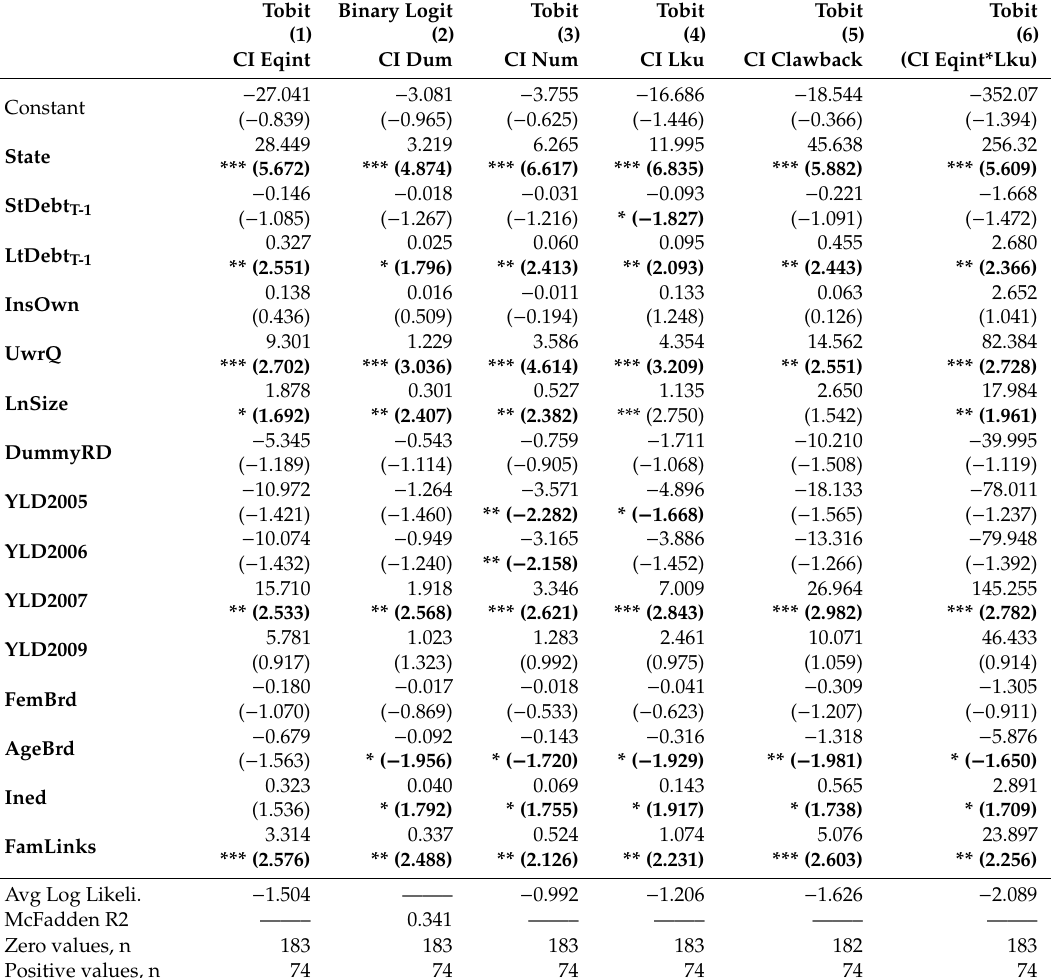
Table 2. Determinants (including AgeBrd) of cornerstone